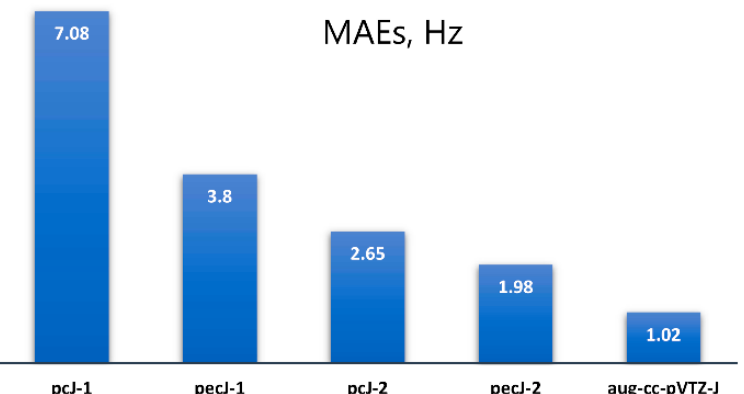
Figure 1. The MAEs evaluated for the SSCCs with phosphorus or/and silicon in molecules 1–20 calculated at the SOPPA(CCSD) level with pcJ-1, pcJ-2, pecJ-1, pecJ-2, and aug-cc-pVTZ-J basis sets against the benchmark data, obtained with the dyall.aae4z + basis set.